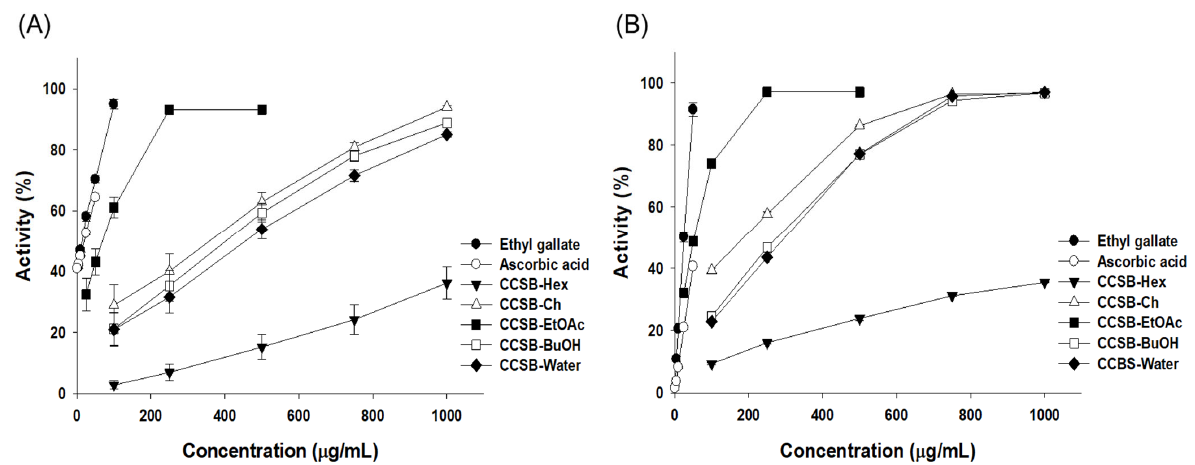
Figure 2. Chemical structure of Compound 1 (ethyl gallate).